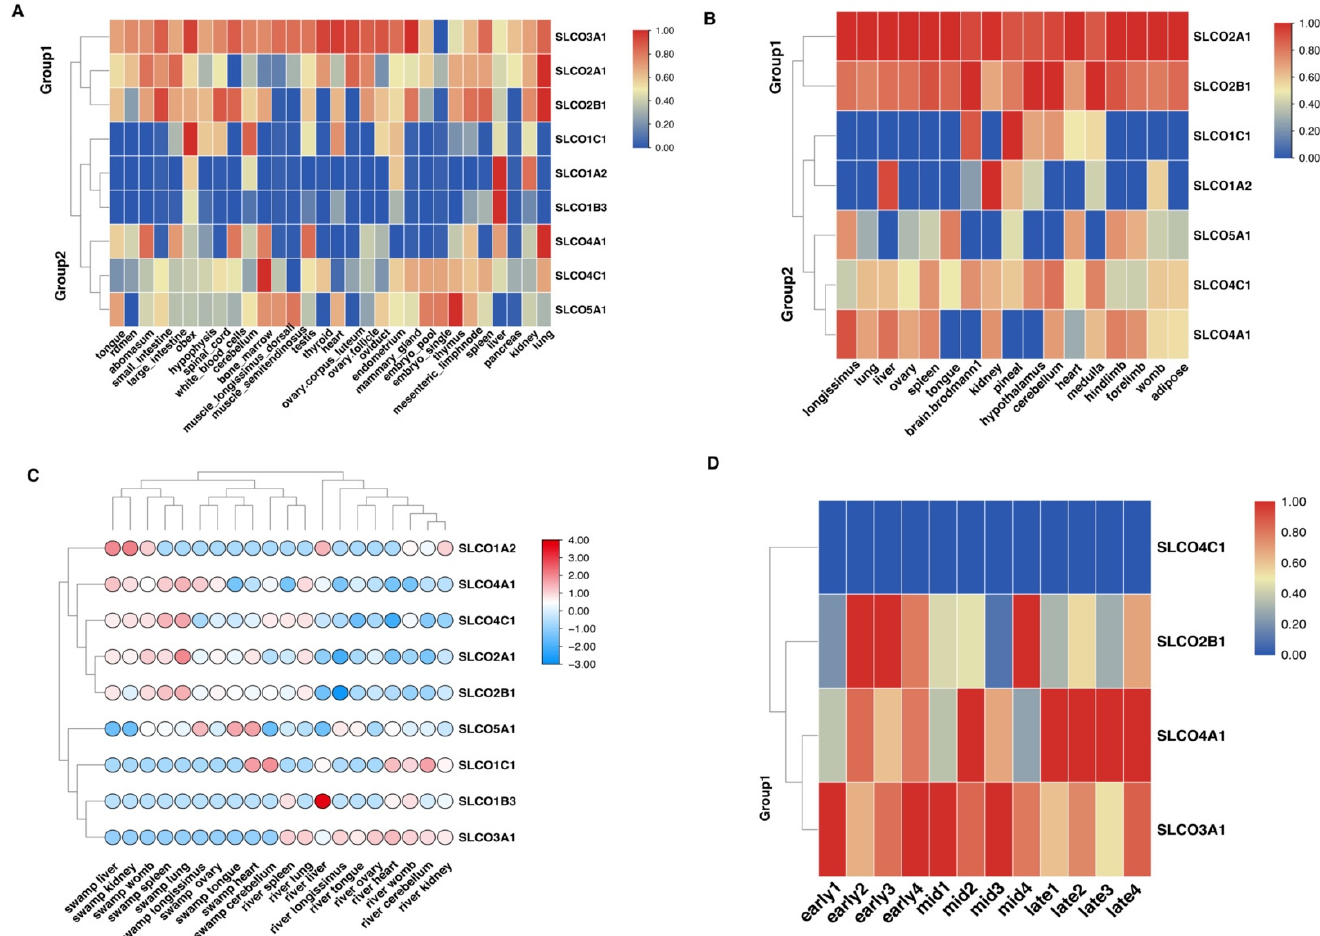
Figure 4. The expression patterns of OAT genes in buffalo subspecies. ( A ) The expression distribution of OAT genes in river buffalo tissues. ( B ) The expression distribution of OAT genes in swamp buffalo tissues. ( C ) The expression differential patterns of orthologous OAT genes between river and swamp buffalo. ( D ) The expression patterns of OAT genes in buffalo milk samples at different lactation.